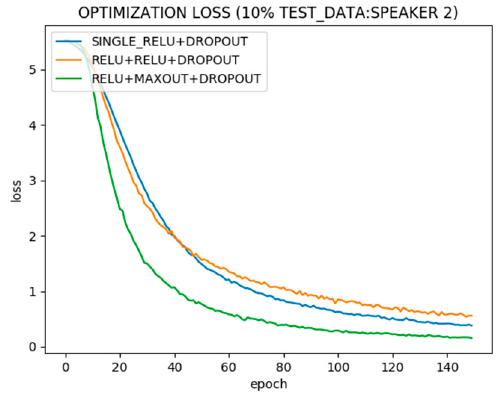
Figure 5. Training error vs. iterations for network architectures.